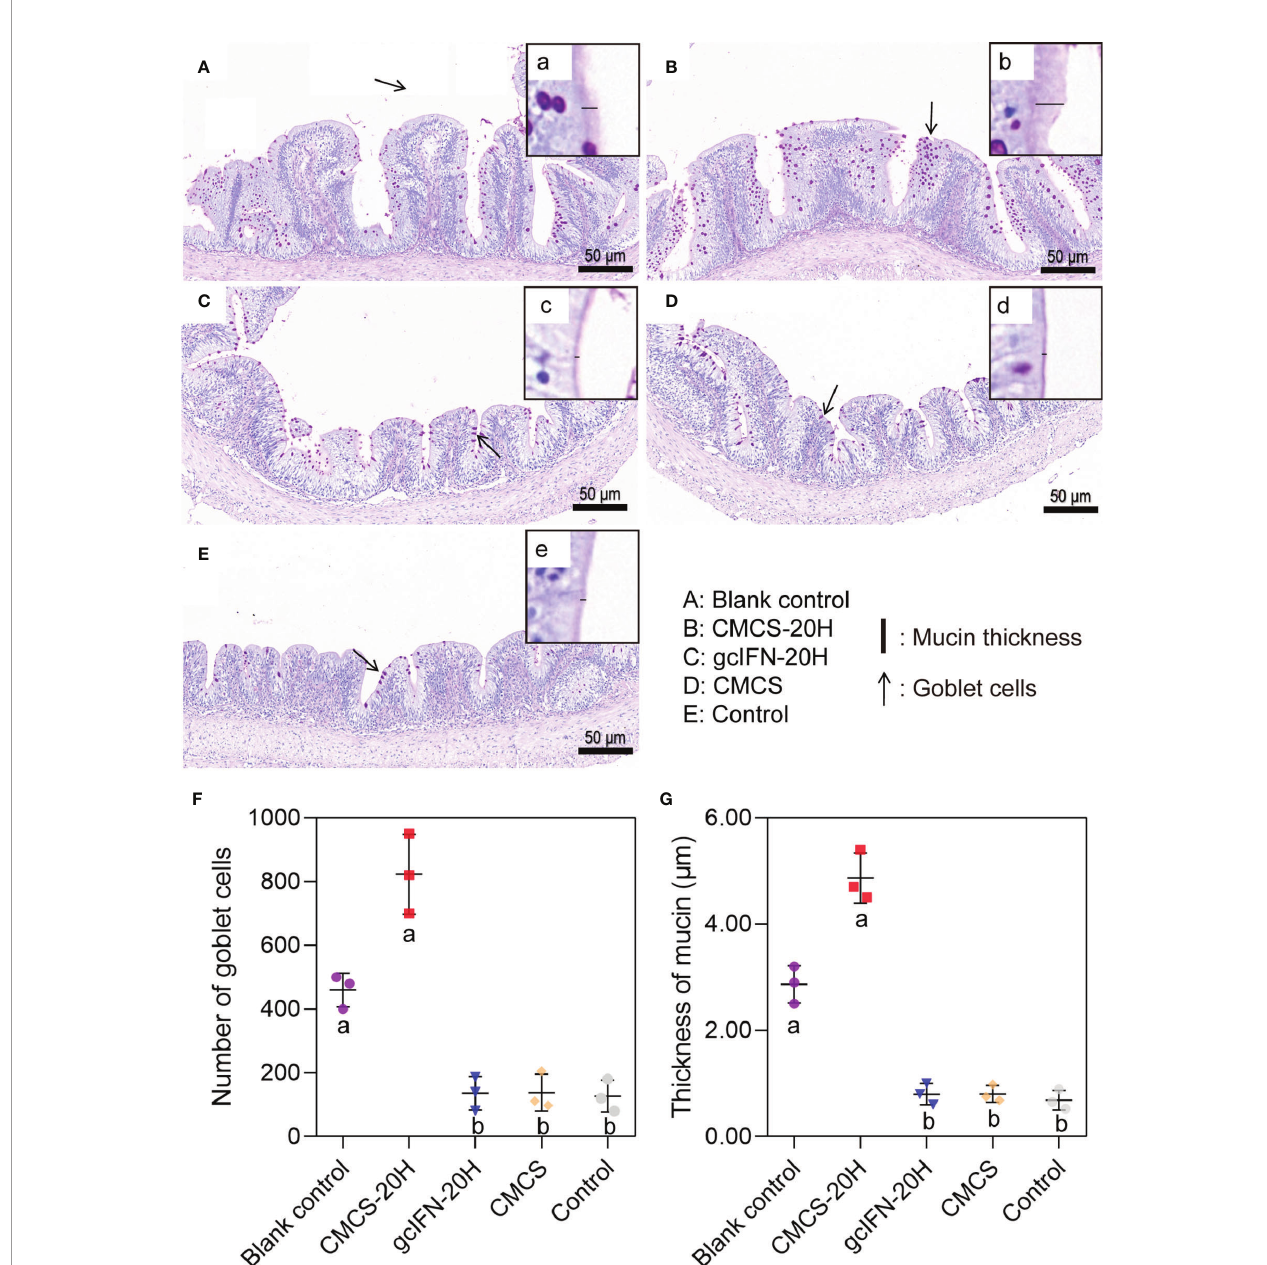
FIGURE 5 | Mucus barrier investigations in grass carp intestine. (A – E) PAS staining of intestine section. The goblet cells are marked with black arrows. (a – e) Magni fi cation of black box region to show the mucin thickness. The thickness of mucin was measured with a black line segment. (F) The number of goblet cells. Three fi elds (×20) were selected for goblet cell count. (G) The thickness measurement of mucin. Three fi elds (×70) were selected for goblet cell count. Samples were taken on D46. Different lowercase letters in each group (a and b) denote signi fi cant variations suggested by the Kruskal-Wallis statistics followed by the Dunn ’ s multiple comparison (p <